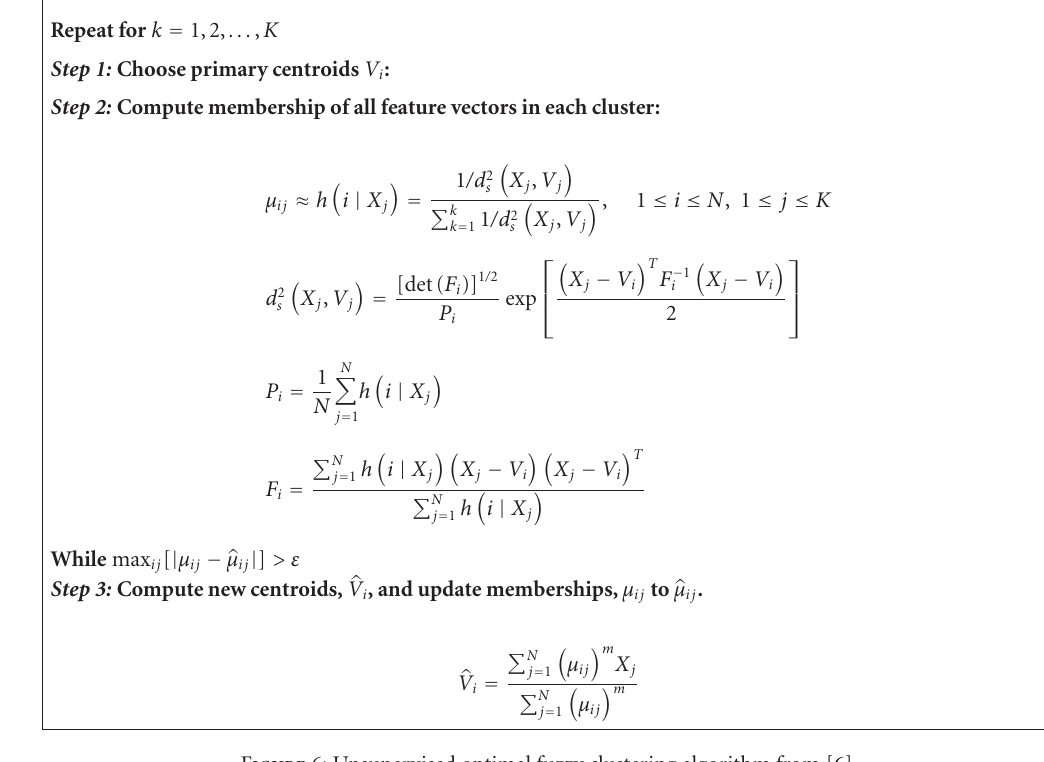
Figure 6: Unsupervised optimal fuzzy clustering algorithm from [6].